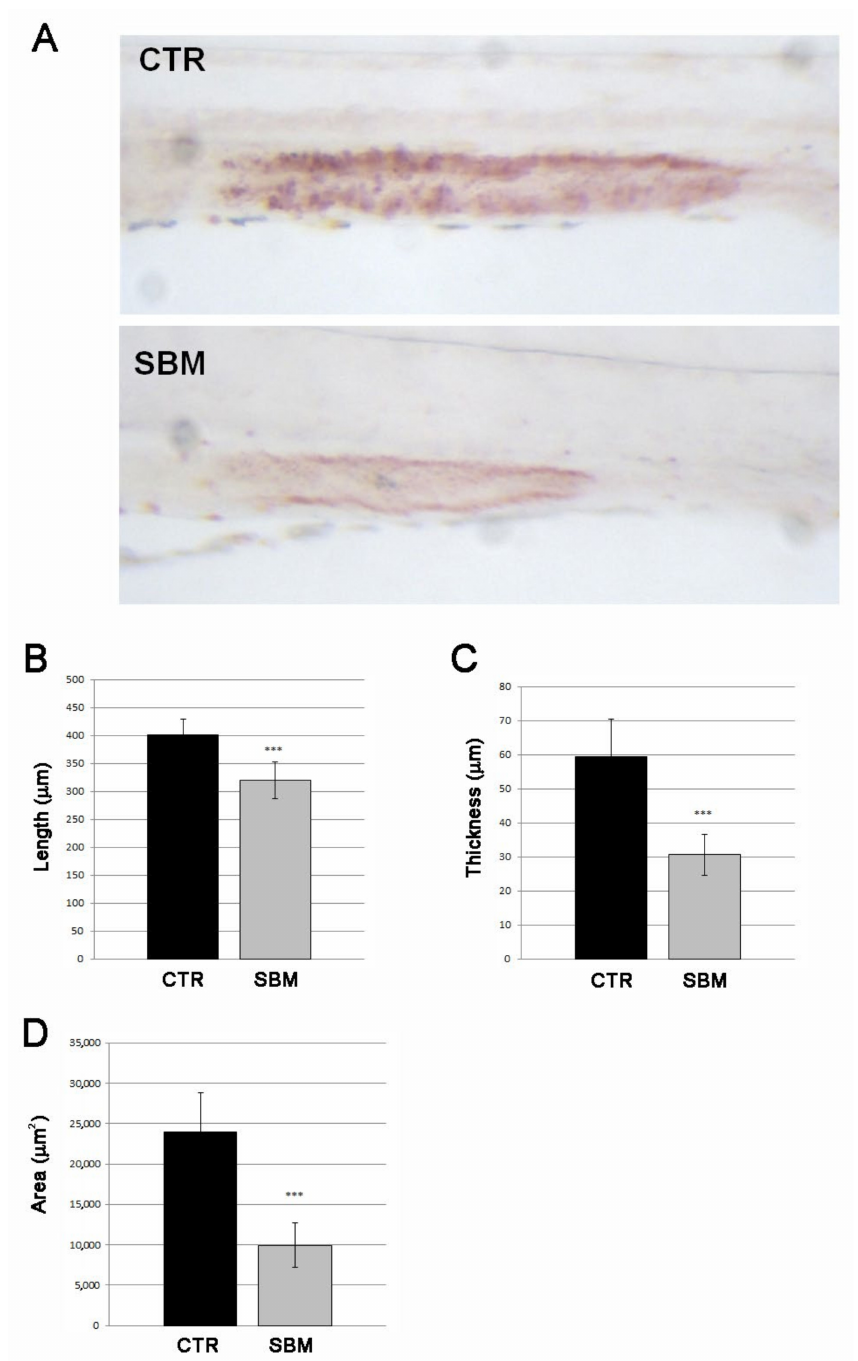
Figure 1. Intestinal effects of SBM. ( A ) Neutral red live staining of mid-intestine in larvae alimented with soy (SBM) or normal diet (CTR) showed decreased intensity of the staining in SBM larvae. Measure of length ( B , SBM vs. CTR, p < 0.001), thickness ( C , SBM vs. CTR, p < 0.001) and area ( D , SBM vs. CTR, p < 0.001) of neutral red staining in controls (CTR) and soy (SBM). Data derived from 10 CTR and 10 SBM larvae, with tests performed 3 times as independent experiments with comparable results and significant differences were evaluated using the Student t -test (*** p <